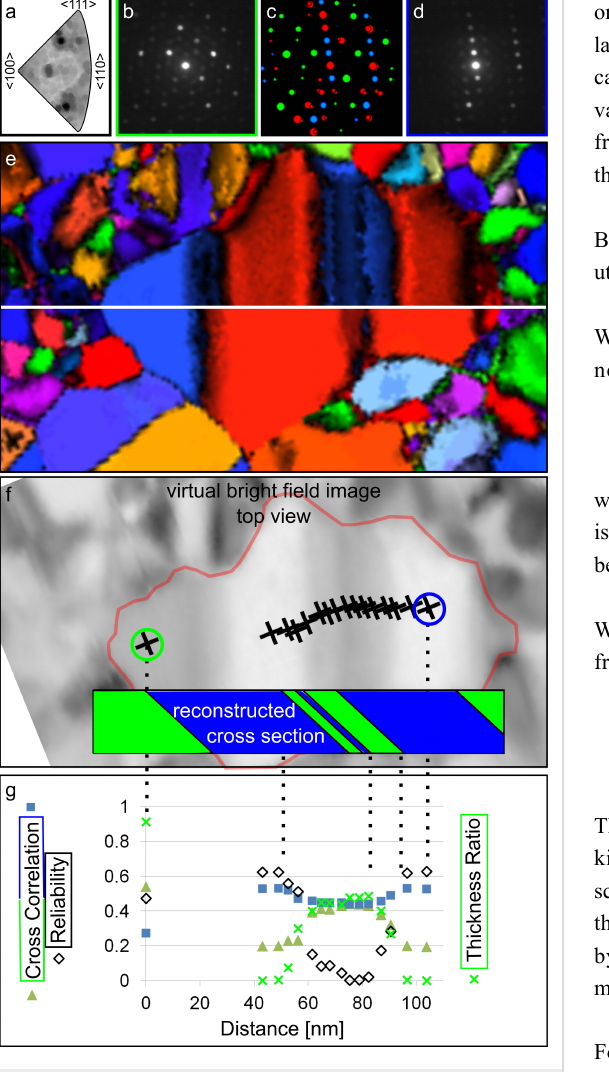
Figure 1: (a) Inverse pole figure (for fcc) with cross-correlation indices of a simulated and experimental diffraction pattern as gray values. The darkest spot has the greatest cross correlation index and determines the best match, and hence determines the orientation of one pixel from an orientation map as shown in (e). (b,d) Spot diffraction pattern of two unique crystal orientations. Positions where (b) and (d) originate from are highlighted in (f) with green and blue circles, respectively. (c) Overlay of both orientations (b green) and (d blue) (red indicates the shared diffraction spots of both orientations). (e) Two halves of an orientation map belonging to the same area and processed with two filter approaches (color code: crystal orientation). (f) Virtual bright field map that highlights one grain with two twin crystallites and the evalu- ated positions. The reconstructed cross section (based on the evalua- tion in (g)) is overlaid. (g) Cross-correlation indices for both orienta- tions (b,d), where reliability and thickness ratio of the (b)-orientation are plotted versus the position of the markers.